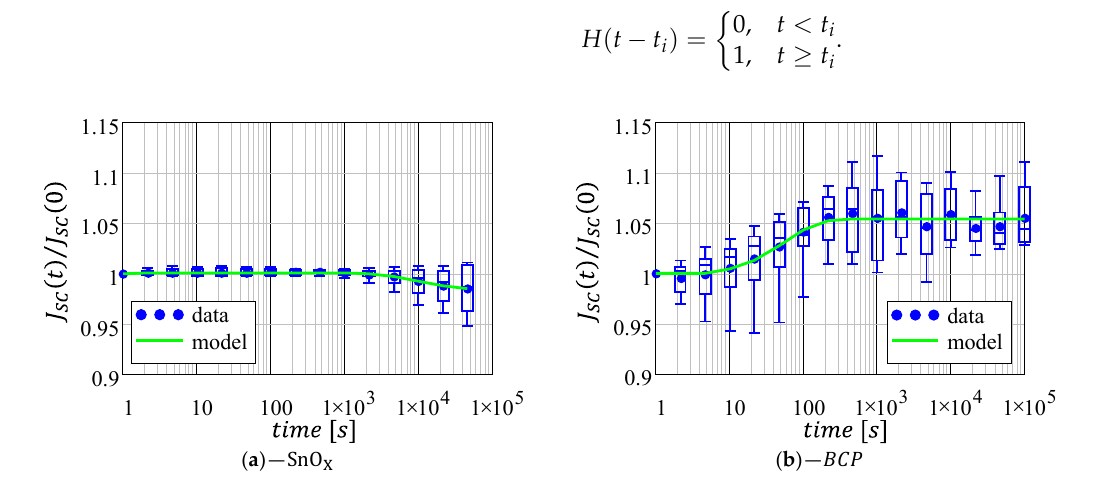
Figure 3. Normalized short-circuit current as a function of time for the two architectures under analysis: ( a ) SnO X -based cells; ( b ) BCP-based cells. Data fitting (green line) was computed using the mean values (blue circles) as a data-set. Plots are reported with the same axis for a direct comparison. Full-scale axes are reported in Supplementary Figure S2.